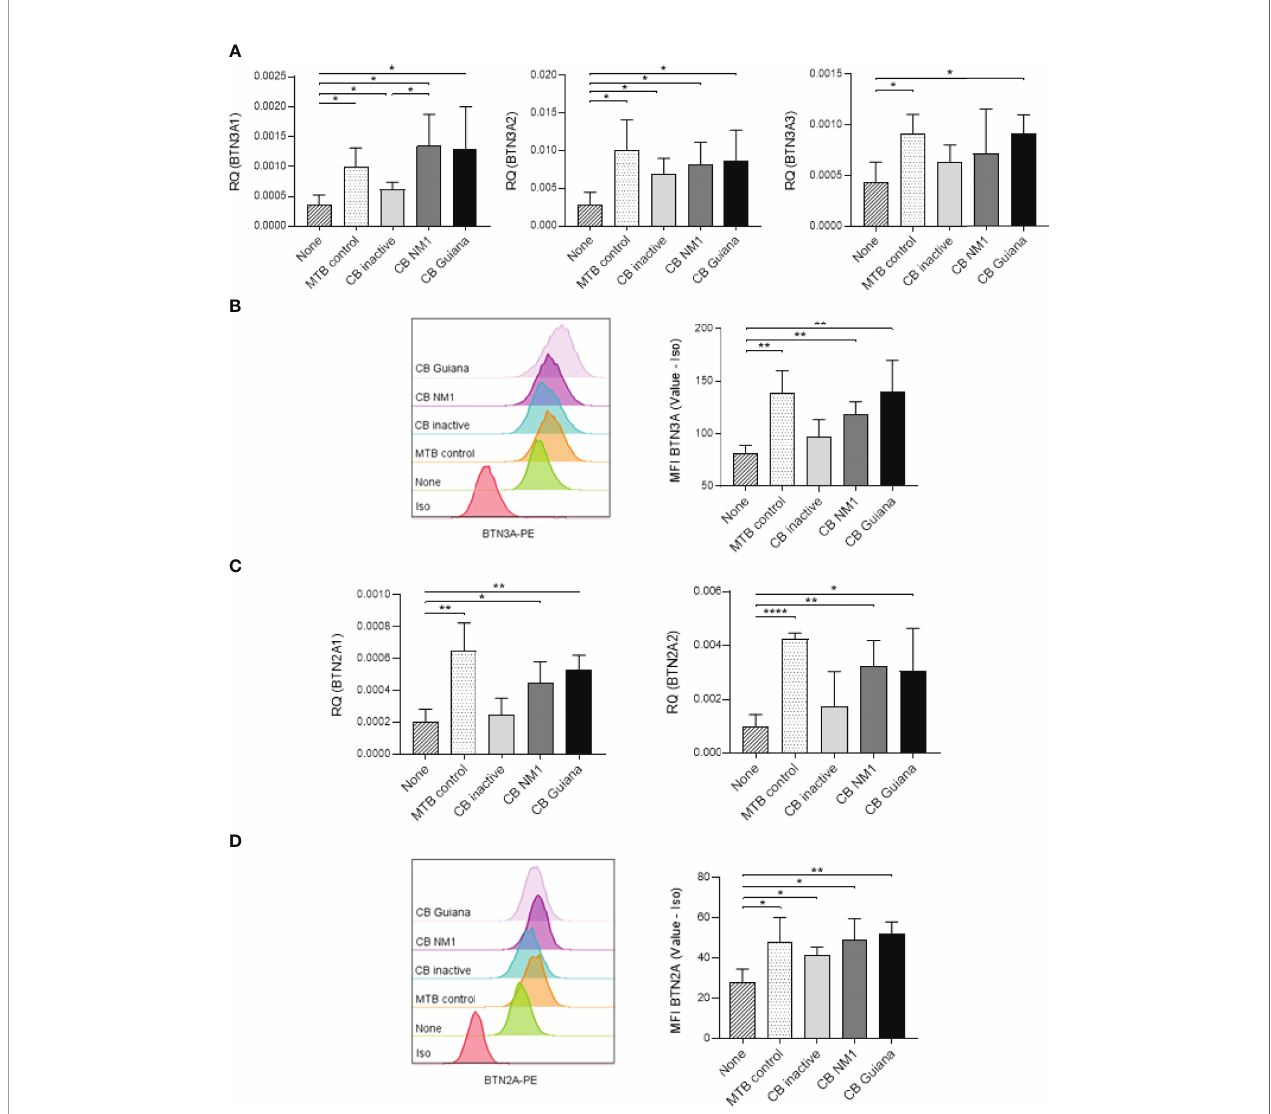
FIGURE 1 | Bacterial infections modulate BTN3A and BTN2A expression. Monocytes isolated from healthy donors (n = 4) were infected with C. burnetii strains (50 MOI) or with M. tuberculosis (5 MOI) for 24 hours. (A) The relative gene expression of BTN3A isoforms (A1, A2, A3) and (B) the BTN3A protein expression were investigated by qRT-PCR and fl ow cytometry, respectively. (C) The relative gene expression of BTN2A isoforms (A1, A2) and (D) the BTN2A protein expression were investigated by qRT-PCR and fl ow cytometry, respectively. Data were analyzed using a normality test and a parametric t test. Values represent mean ± standard deviation. * p < 0.05 , ** p < 0.01 , and **** p < 0.0001